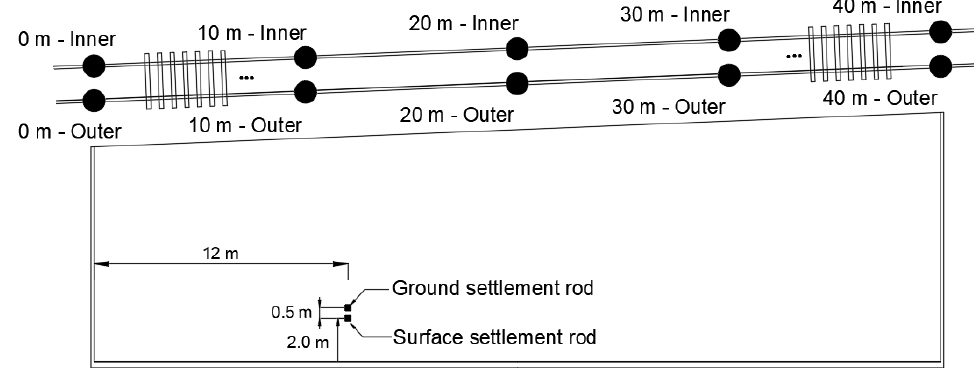
Figure 8. Plan view of the measurement point.